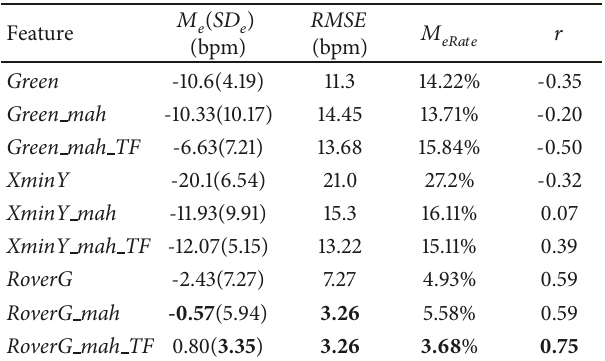
Table1:Comparisonofheartrateestimationusingdifferentfeatures (best performance in